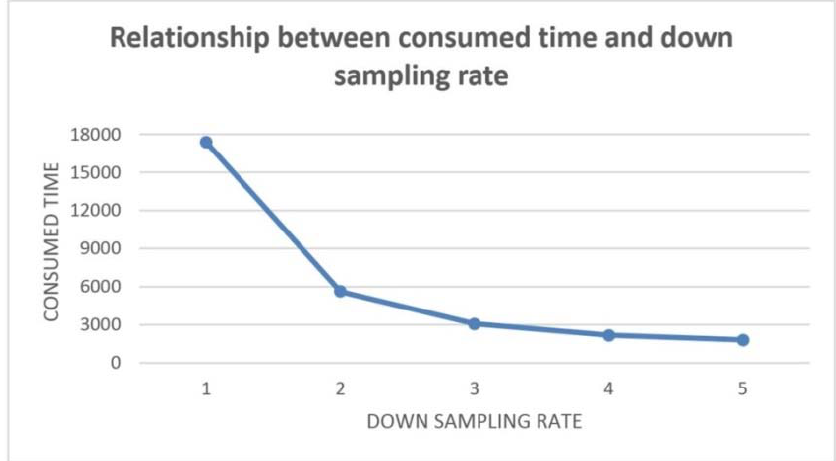
Figure 17. Relationship between processing time and down-sampling rate.